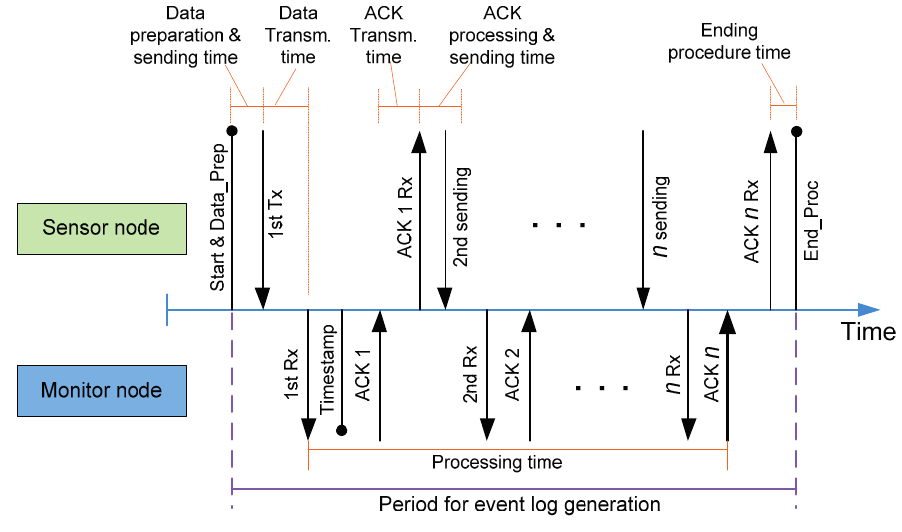
Figure 7. Time outline for event log